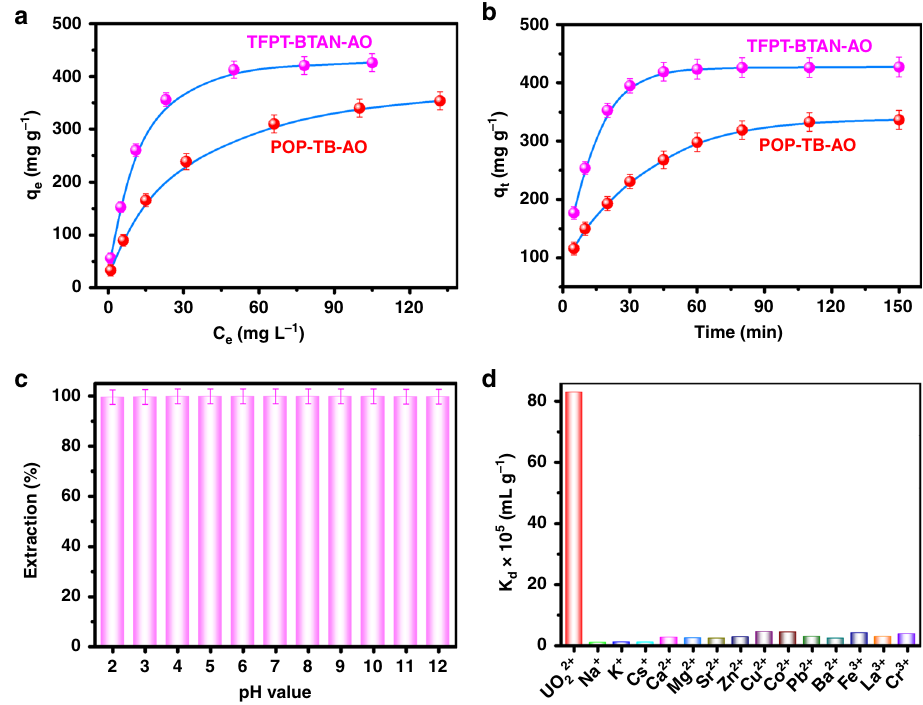
Fig. 6 UO 2 2 + adsorption isotherms and kinetics investigations. a Adsorption isotherm of UO 2 2 + on TFPT-BTAN-AO and POP-TB-AO (pH 4.0). b Adsorption kinetics of UO 2 2 + on TFPT-BTAN-AO and POP-TB-AO (pH 4.0). c The removal ef fi ciency of UO 2 2 + under different pH conditions. d The selective adsorption of the test ions. Error bars represent S.D. n = 3 independent